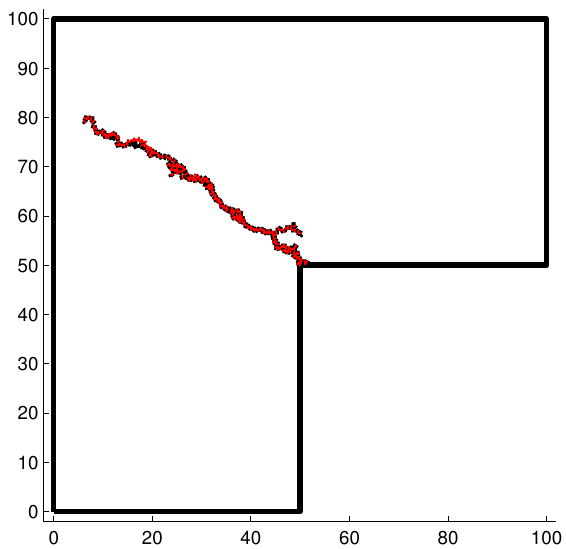
Figure 2. Broken links computed with exact particle approach A0 (black) and with QC approach with local anisotropic homogenization A3 (red).